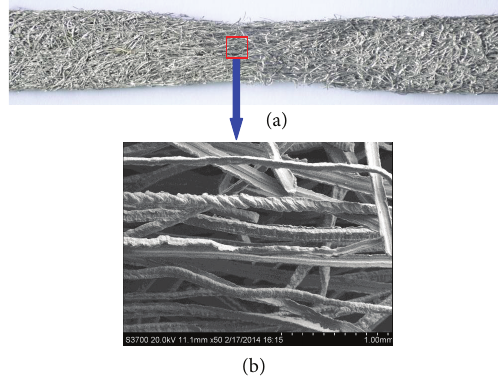
Figure 8: Failed sample with 80% porosity sintered at 1000 ∘ C for 60 min after tension test. (a) Fracture appearance, (b) SEM image of fracture